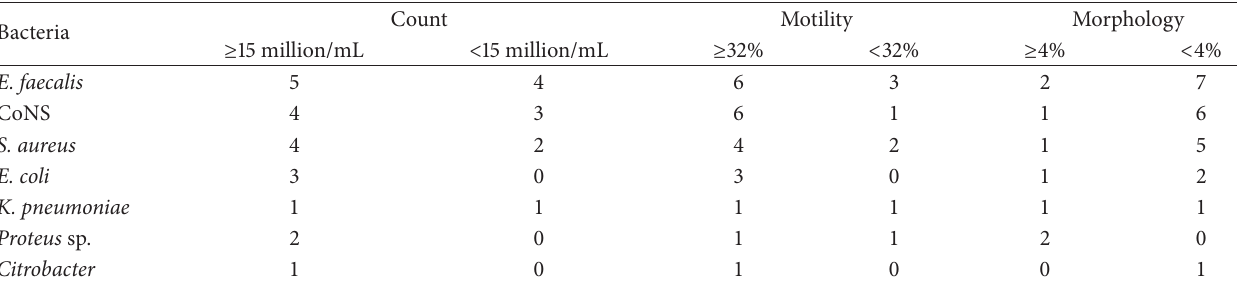
Table 4: Semen parameters among various bacterial species.